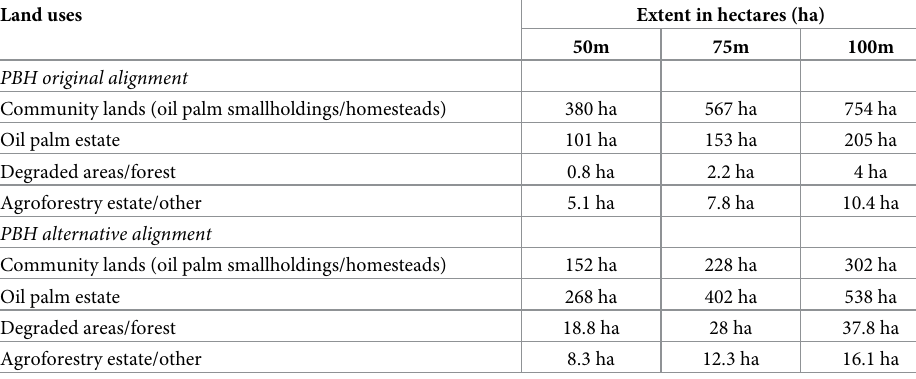
Calculations of the extents (in hectares) of land uses identified within the original Pan Borneo Highway (PBH) alignment for work packaged 22 to 26, compared to land uses identified within the alternative alignment, under three width scenarios of 50m, 75m and